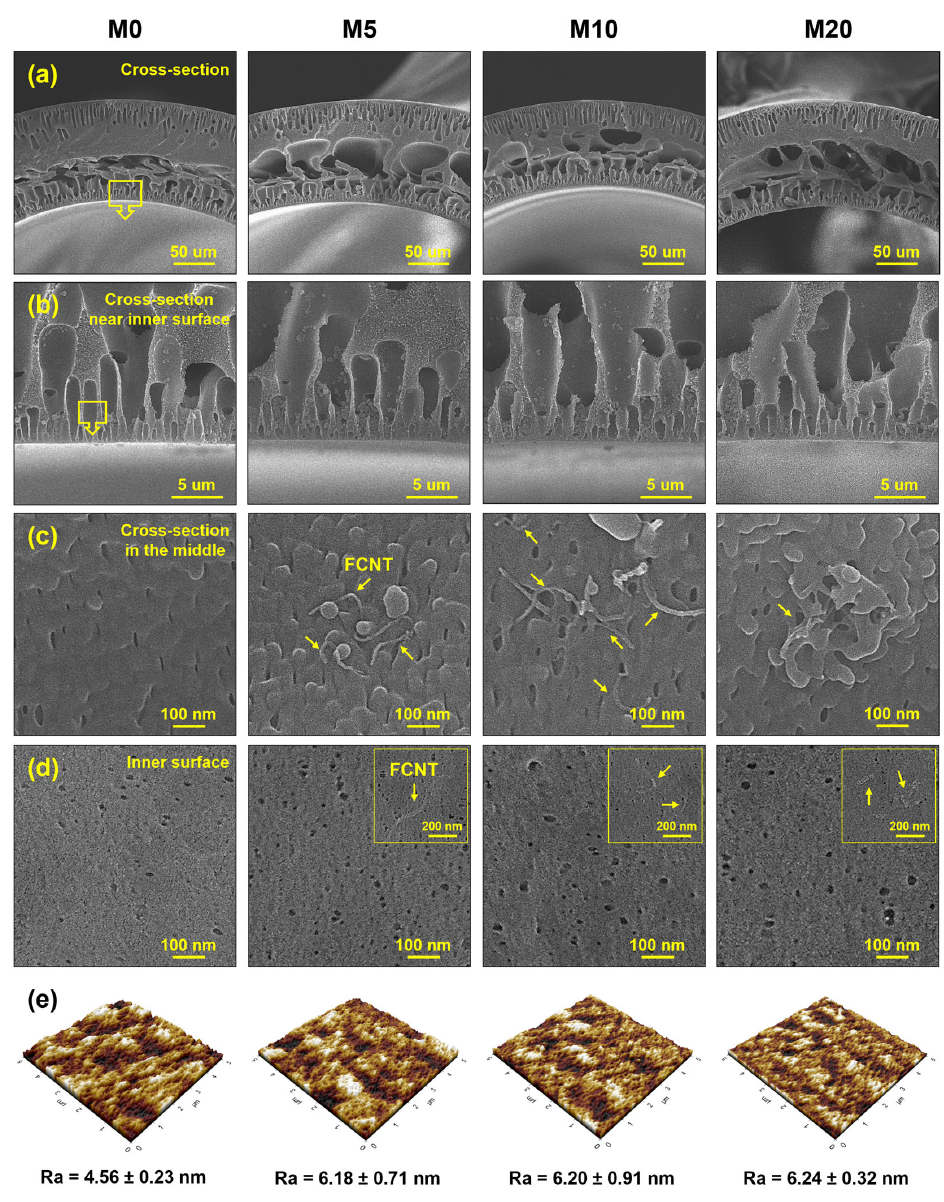
Figure 3. Microstructure of PES and FCNT/PES nanocomposite HF membranes. ( a – c ) Cross ‐ section. ( d ) Inner surface. ( e ) Inner surface roughness. The roughness of the membrane surface affects filtration and antifouling